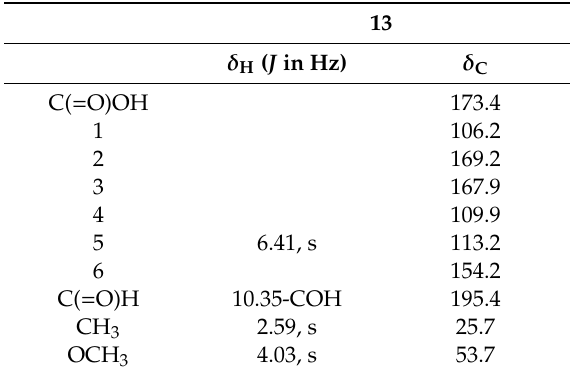
Table 1. 1 H and 13 C NMR spectroscopic data for compound 13 (in acetone- d 6